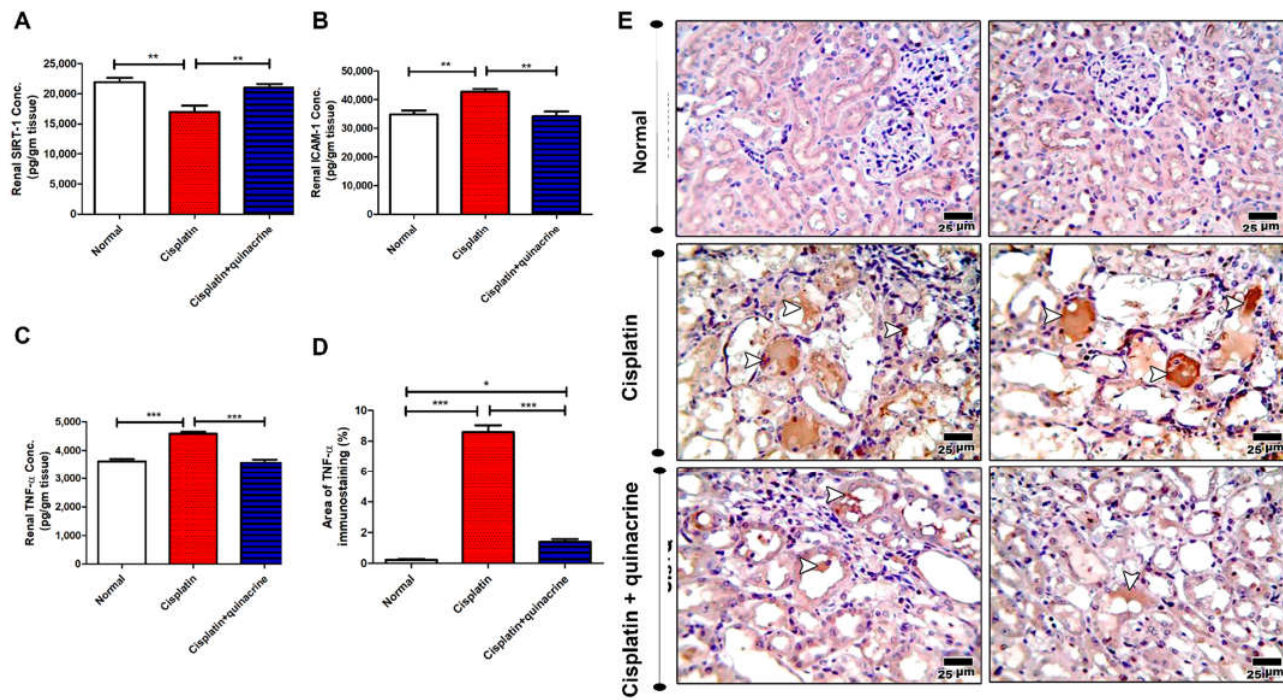
Figure 3. Quinacrine attenuated cisplatin-induced dysregulation of SIRT-1, ICAM-1 and TNF-α. Effect of quinacrine administration (10 mg/kg/rat/ day: i.p) against cisplatin-induced nephrotoxicity in rats on ( A ) renal sirtuin-1 (SIRT-1) concentration ( n = 7–8), ( B ) renal intercellular adhesion molecule-1 (ICAM-1) concentration ( n = 7–8), ( C ) renal tumor necrosis factor-α (TNF-α) concentration ( n = 7–8) and ( D ) % area of TNF-α immunostaining ( n = 6). ( E ) Microscopic pictures of immunostained renal sections against TNF-α showing negative expression in normal group and strong positive tubular expression appears in affected areas in renal sections from cisplatin group. The positive brown tubular expression decreased in renal sections from cisplatin + quinacrine group. (Arrowheads point to positive brown reaction.) High magnification X:400 bar 25. *: p < 0.05; **: p < 0.01 and *** p < 0.001. Data are expressed as mean ± SEM.